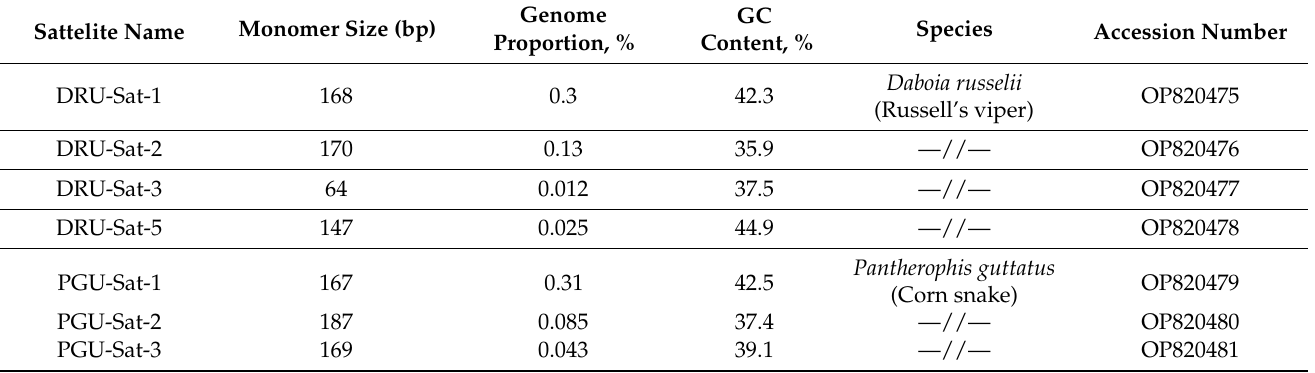
Table 2. Putative satellites revealed by TAREAN in the genomes of Daboia russelii and Pantherophis guttatus .